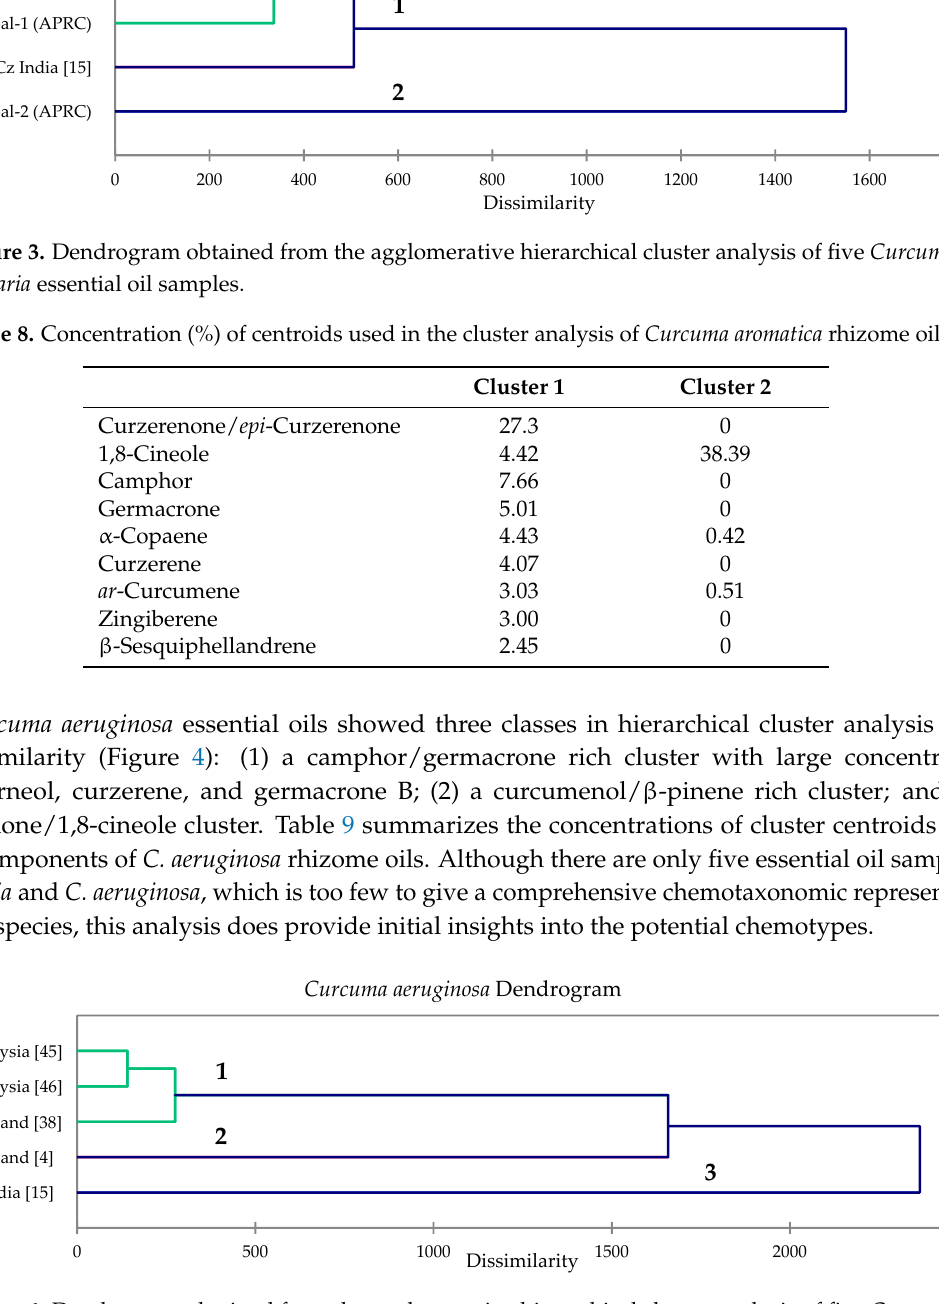
Figure 4. Dendrogram obtained from the agglomerative hierarchical cluster analysis of five Curcuma aeruginosa essential oil compositions. Table 9. Concentration (%) of centroids used in the cluster analysis of Curcuma aeruginosa rhizome oils.